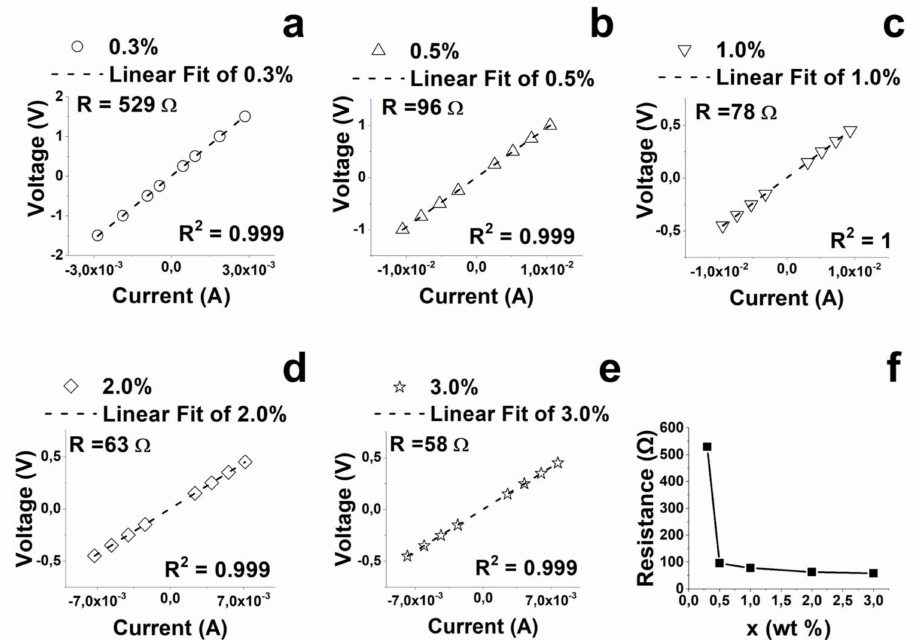
Figure 2. Results of the measurements voltage–current for filled systems: ( a ) 0.3%, ( b ) 0.5%, ( c ) 1.0%,